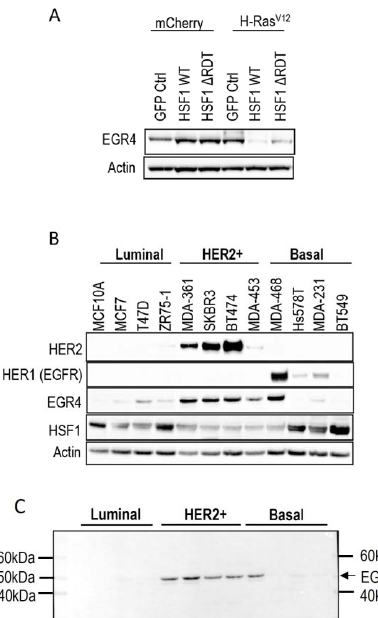
Figure 1. Association of EGR4 with HSF1 and HER2/HER1 expression in breast cell lines. ( A ) EGR4 protein expression in non-transformed breast cells (mCherry) and oncogenically transformed breast cells (H-Ras V12 ) with low (GFP Ctrl) and high HSF1 (HSF1 WT, HSF1 Δ RDT). ( B ) Protein expression in a panel of breast cancer cell lines of different cancer sub-types (Luminal, HER2+, Basal). ( C ) Merged light/chemiluminescent image showing molecular ladder (left and right) and EGR4 protein bands detected around ~51 kDa.